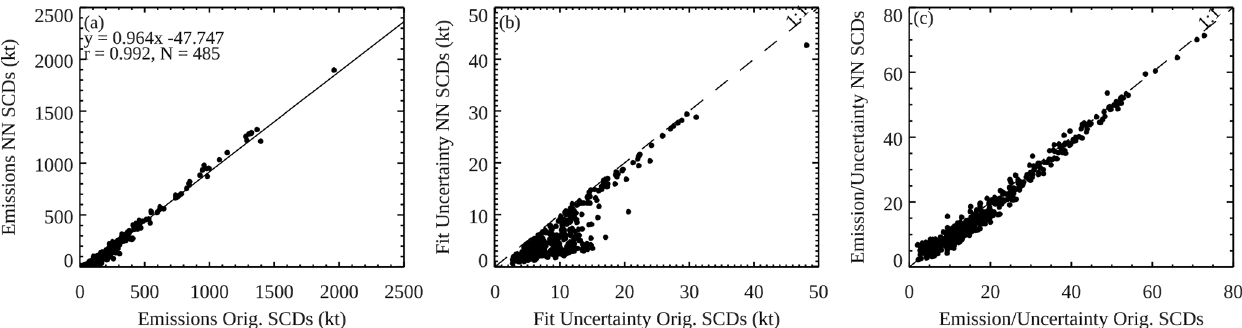
Figure 9. Scatter plots comparing (a) the annual emission estimates for 485 large point sources for 2005, (b) the uncertainties in the emission estimates, and (c) the ratios between the emission estimates and the uncertainties using the NN-analyzed vs. the original SCDs. All sources shown here are anthropogenic and have emission estimates at least twice the uncertainties for both